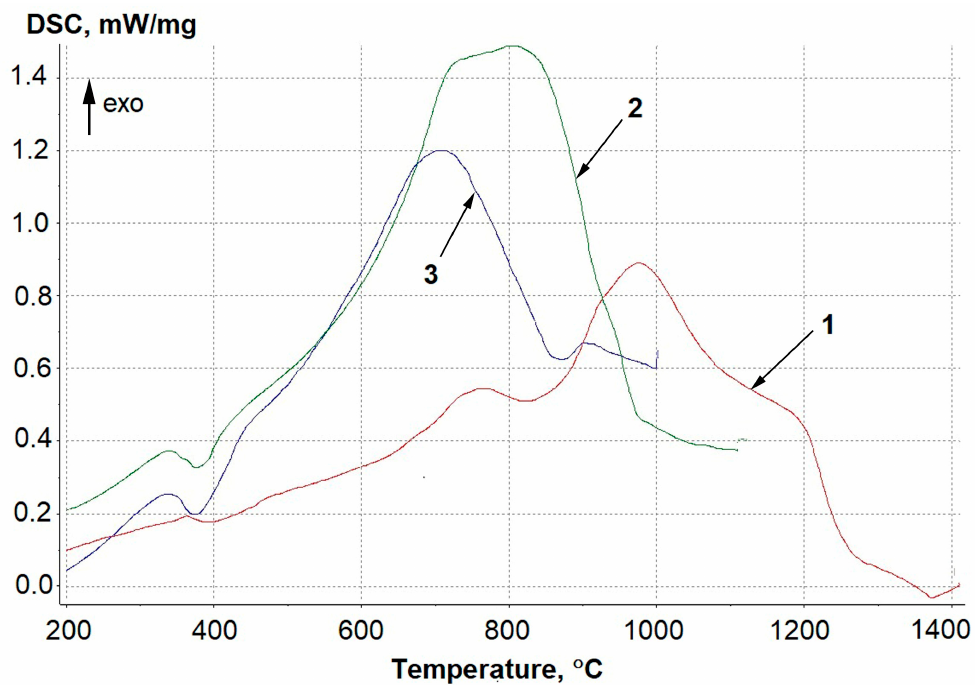
Figure 4. Results of DSC studies of samples of «niobium + nanodiamonds» composites: 1—after 0.5 h of processing (specimen 1-Nb); 2—after 1.2 h of processing (specimen 2-Nb); 3—after 6 h of processing (specimen 3-Nb).